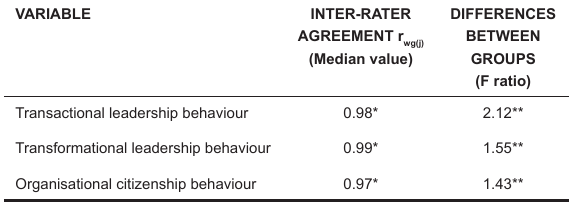
TABLE 1 Inter-rater agreement and differences between groups (n =